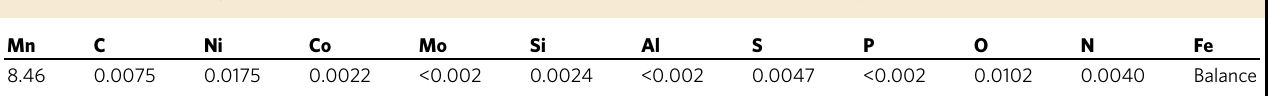
Table 1 Chemical composition of Fe-9 wt.% Mn in wt.% according to wet-chemical analysis